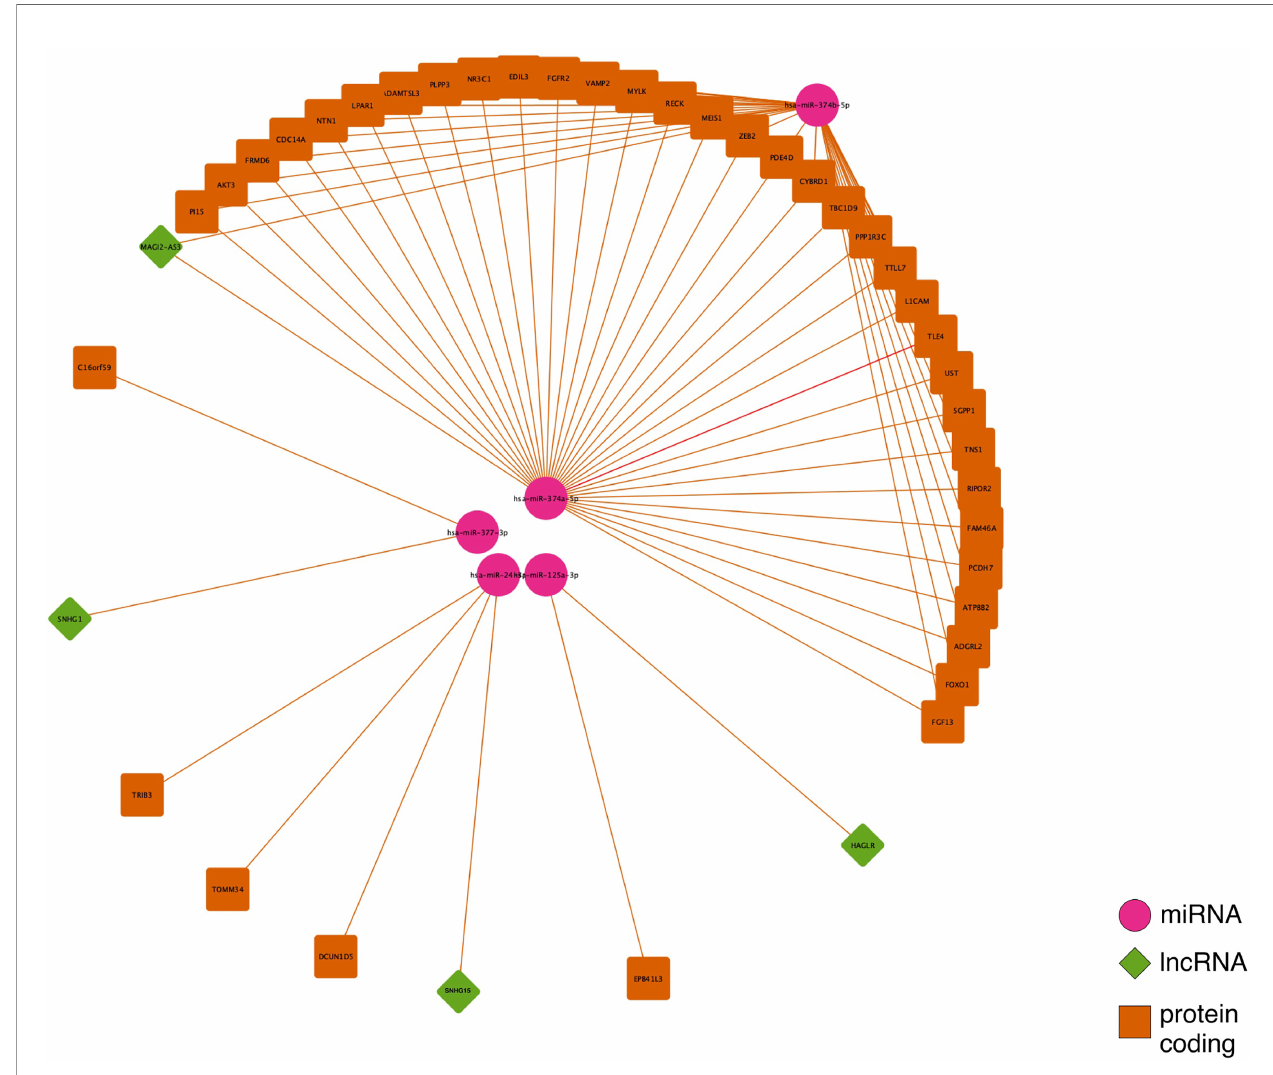
FIGURE 3 | Competing endogenous RNA (ceRNA) network intersection for colon, rectum and rectosigmoid junction